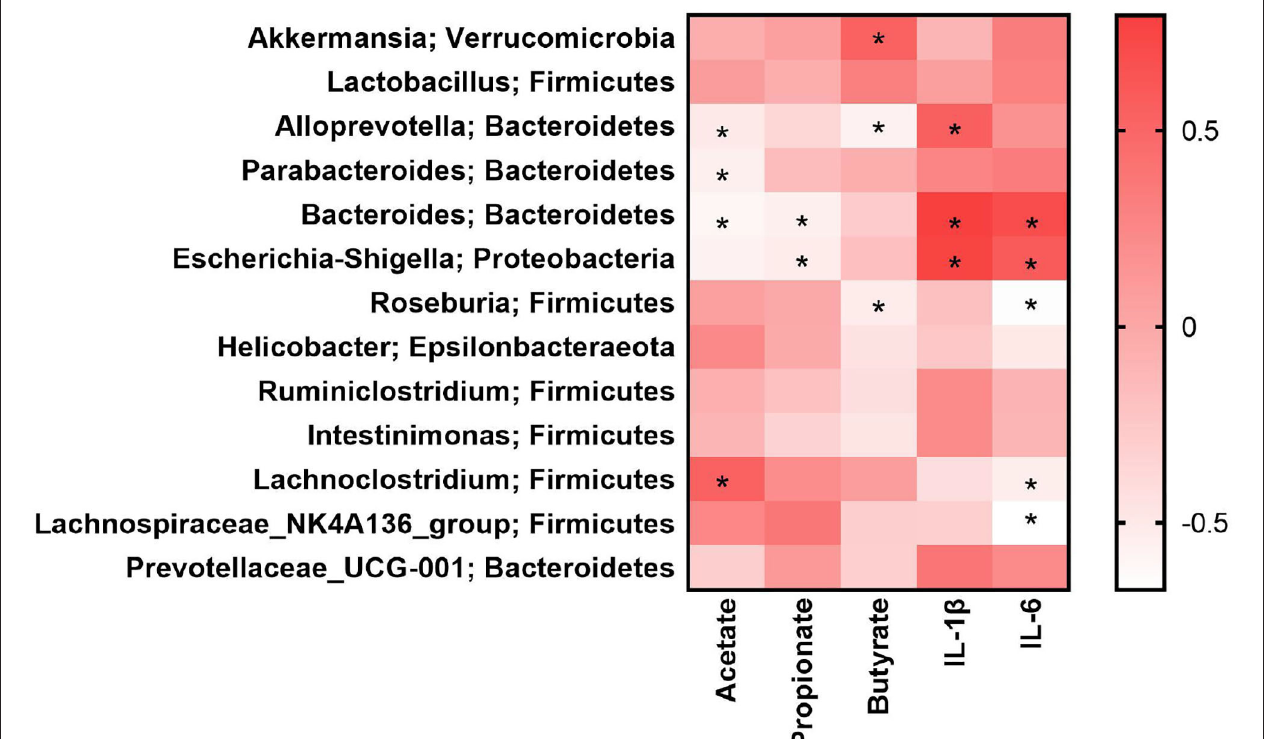
FIGURE 6 | Gut microbiota was related to SCFA and inflammatory factors in LPS-induced mice. * P <